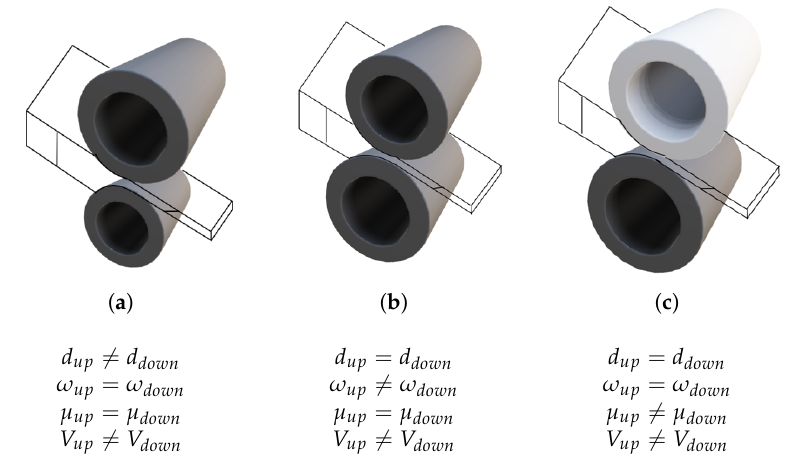
Figure 1. Asymmetric rolling process methods and